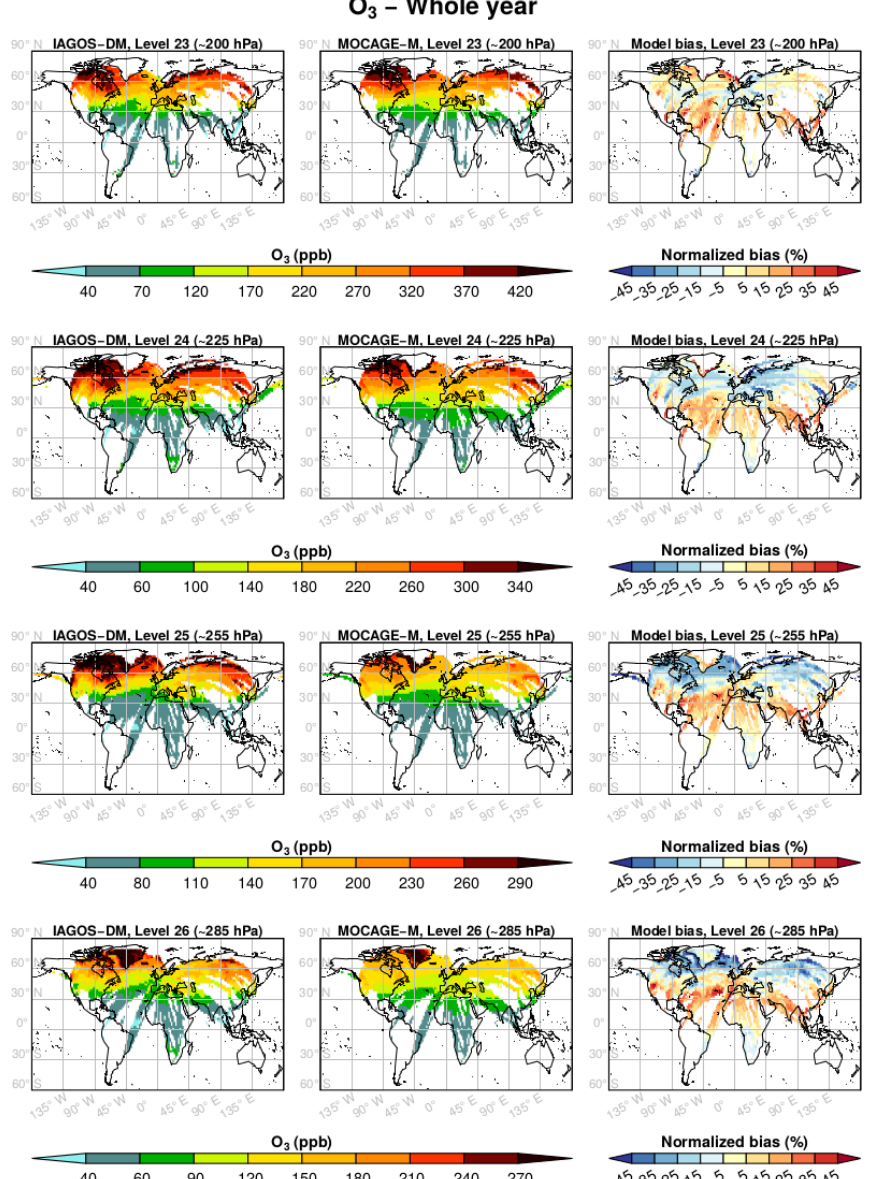
Figure 3. Mean horizontal distribution of the O 3 mixing ratio (ppb) from the model levels 26 ( ∼ 320hPa, bottom panels) to 23 ( ∼ 200hPa, top panels) in IAGOS-DM (left panels) and MOCAGE-M (middle panels) during the period December 1994–November 2013. The normal- ized bias is represented in the right panels, in percentage with respect to the average between the two data